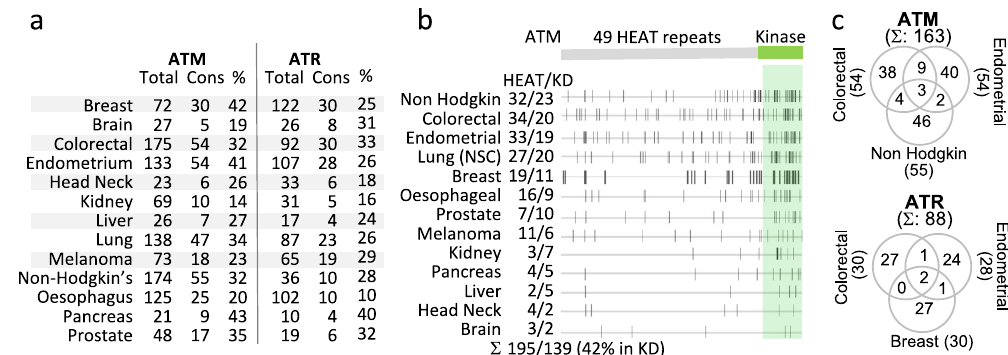
Fig. 2 Tissue speci fi city of conserved ATM/ATR residues mutated in cancer. a Extent of conservation in the ATM and ATR residues mutated in the indicated cancer type. “ Total ” : the total number of ATM or ATR residues mutated in the indicated cancer type (Supplementary Data 1 and 2). “ Cons ” : the number of mutated residues that are conserved in yeast Mec1 and/or Tel1 (Supplementary Data 3 and 4). “ % ” : the fraction of conserved residues. b Location of the conserved ATM residues mutated in the indicated cancer type (Supplementary Data 3). The human ATM polypeptide comprises 49 HEAT units and a kinase domain. “ HEAT/KD ” : the number of residues in the respective regions. Overall, 42% (139/336) of the conserved residues mutated in cancer are in the kinase domain. c Extent of overlap among the conserved ATM and ATR residues mutated in the indicated cancer type (Supplementary Data 3